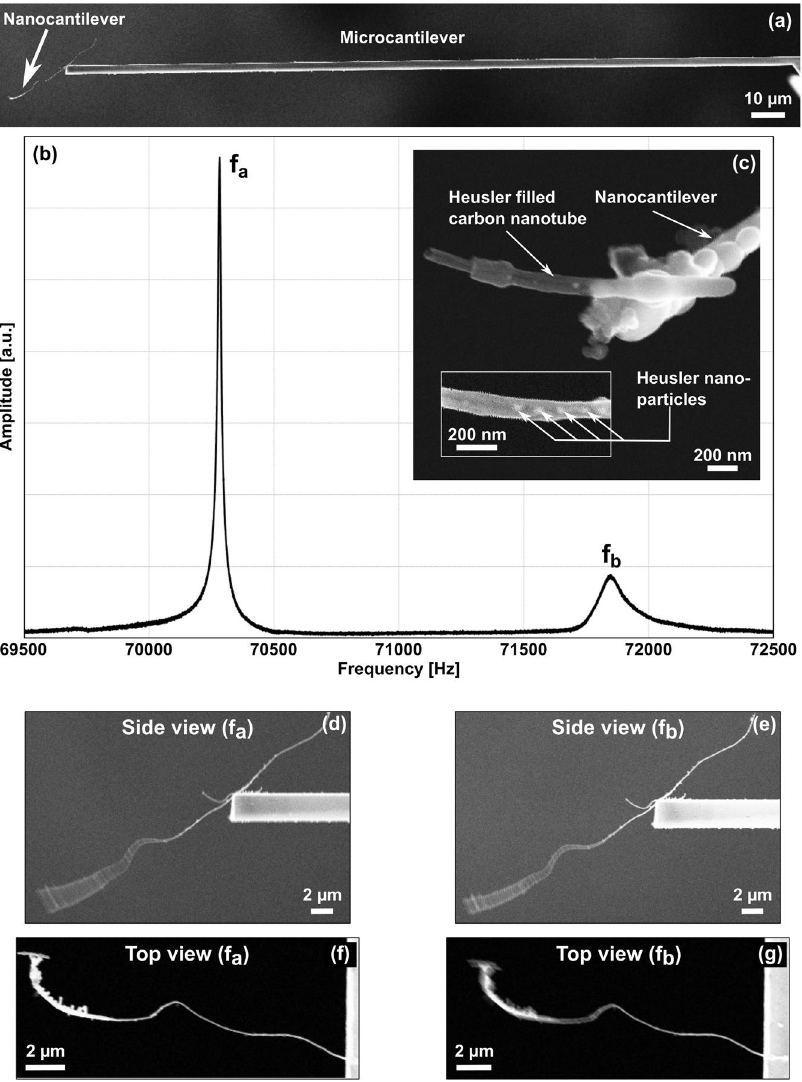
Figure 1. ( a ) Scanning electron microscopy (SEM) image of the co-resonantly coupled sensor consisting of a commercially available silicon microcantilever and a carbon nanotube as nanocantilever. ( b ) Amplitude response curve for the sensor obtained at the microcantilever which clearly shows the two resonance peaks with the frequencies f a and f b . ( c ) Heusler filled carbon nanotube placed at the end of the nanocantilever. The inset shows a magnification where some of the Heusler particles are visible. ( d ) Side view of the oscillating nanocantilever at f a , ( e ) side view of the oscillating nanocantilever at f b , ( f ) top view of the oscillating nanocantilever at f a , ( g ) top view of the oscillating nanocantilever at f b observed inside the SEM. The excitation parameters were the same for ( d , f ) as well as ( e , g ).